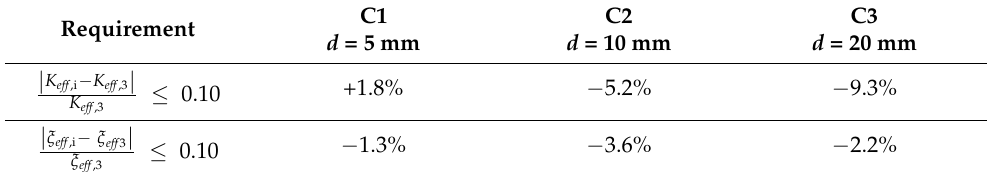
Table 2. Stability requirements [53] and results of the tests on the PS-LED prototype.